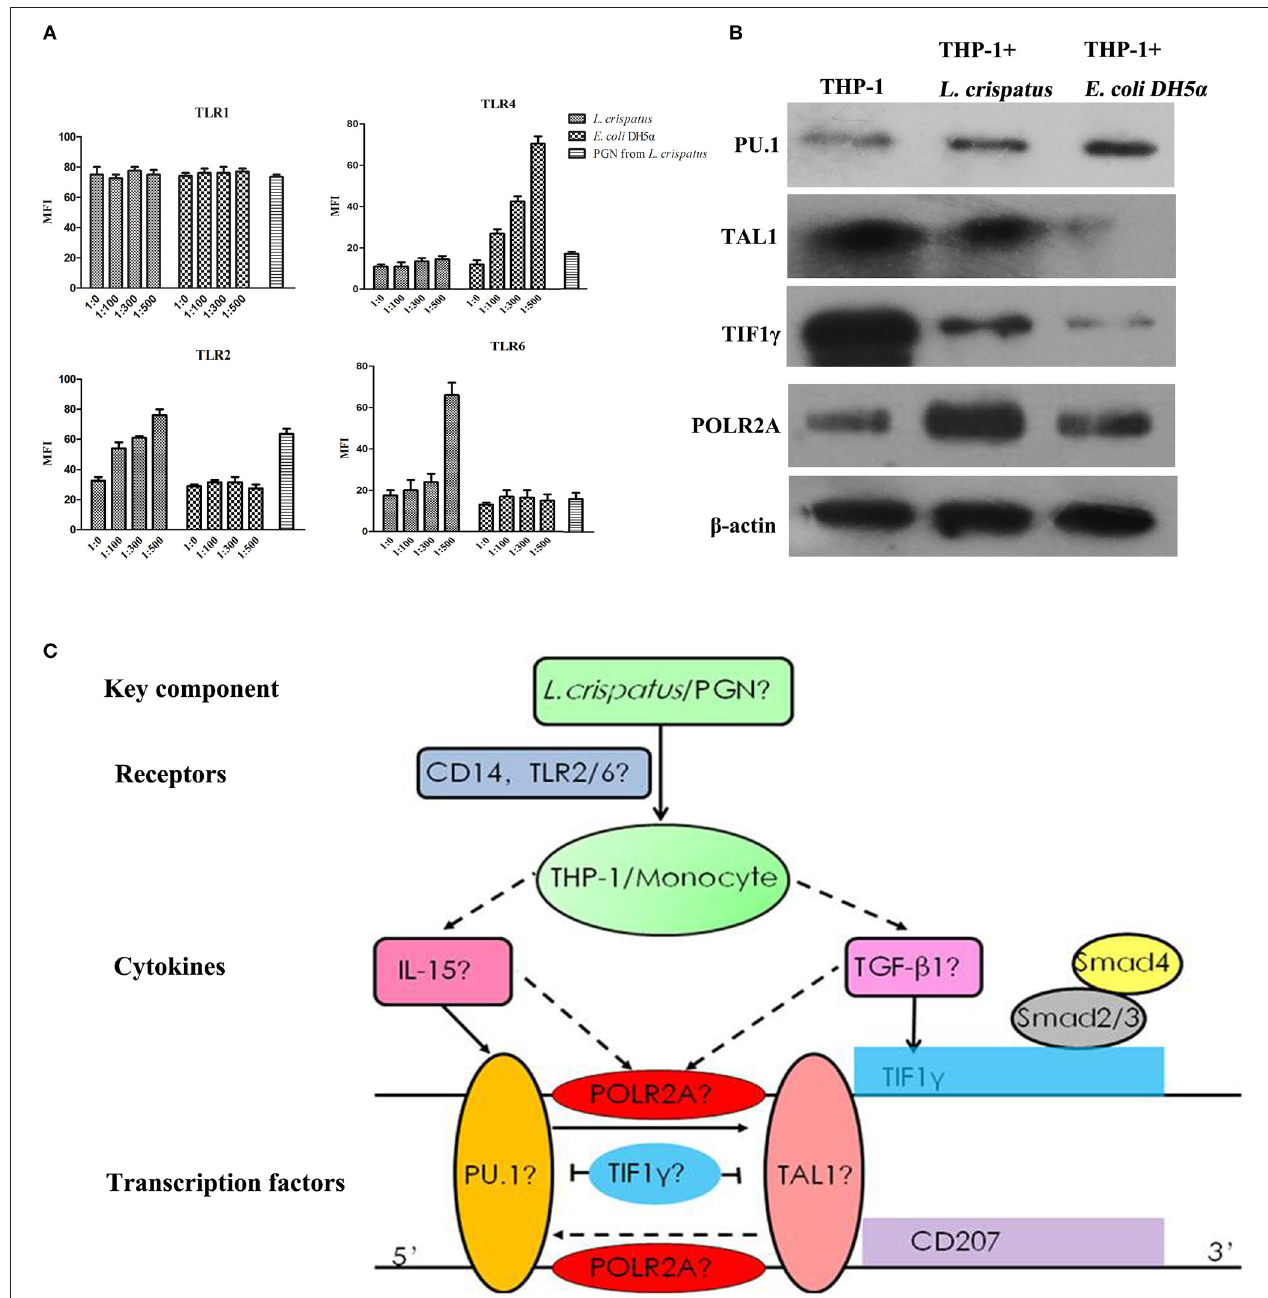
FIGURE 8 | TLRs and transcription factors in THP-1 cells induced by L. crispatus. (A) L. crispatus enhanced TLR2 and TLR6 expression in THP-1 cells in a concentration-dependent manner. TLR1, 2, 4 and 6 were detected by flow cytometry after treated with L. crispatus, E. coli DH5 α at the ratio of 1: 0, 1: 100, 1: 300, and 1: 500 or PGN from L. crispatus at 1 mg/ml. (B) Comparisons of the protein levels of PU.1, TAL1, TIF1 γ , and POLR2A in THP-1 cells induced by L. crispatus and E. coli DH5 α . (C) Roadmap for this study. L. crispatus might be recognized by TLR2 and TLR6 in THP-1 cells and then activate the related TFs of the GM-CSF with IL-15 or IL-4 and TGF- β 1 signaling pathways, which can ultimately lead to CD207 expression. did not express CD207, we chose L. fermentum as a negative sacculus decorated with proteins, LTAs and polysaccharides, and control. We found that SLP was present in L. crispatus , but not is surrounded in some species by an outer shell of proteins packed in L. fermentum , and SLP isolated from L. crispatus did not in a paracrystalline layer (S-layer) (41). Hence, we extracted promote CD207 expression. Notably, in addition to the SLP of different components of the cell wall of L. crispatus to screen for L. crispatus , the remaining components of the L. crispatus the key player, and since THP-1 cells treated with L. fermentum